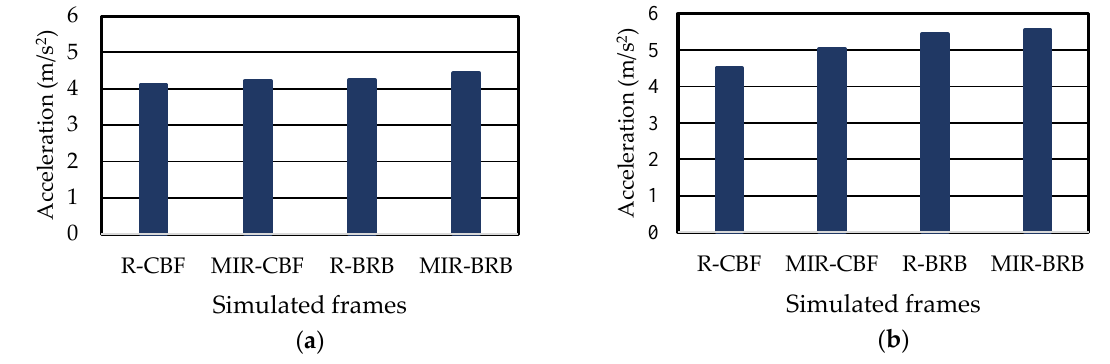
Figure 9. Average acceleration comparison of ( a ) 10-story frames and ( b ) 15-story frames.